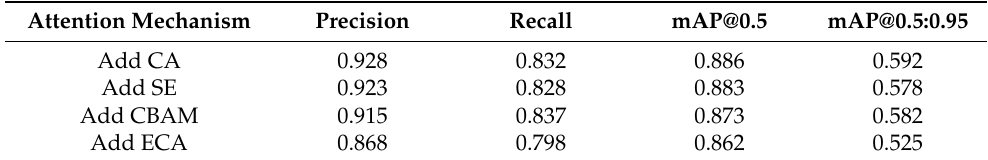
Table 3. Comparison of the models with CA, SE, CBAM, and ECA attention modules added to the Backbone layer. Attention Mechanism